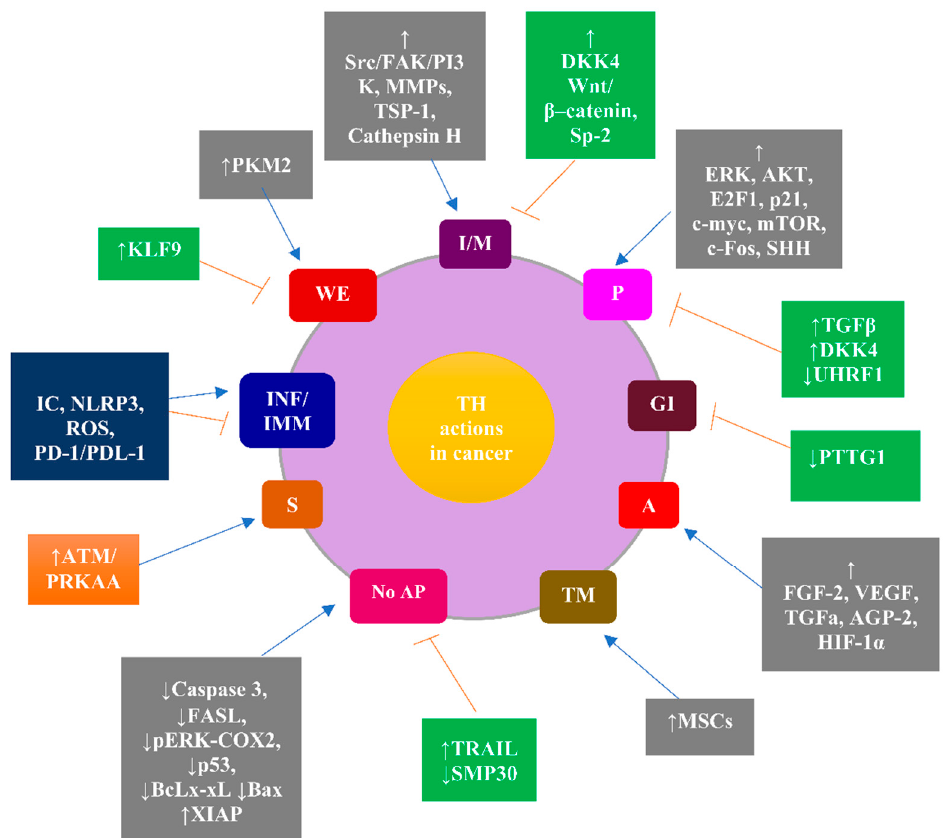
Figure 2. The contribution of THs to cancer hallmarks and to the senescence of cancer cells inte- grated by THs-modulated signaling molecules. Blue arrow: stimulation; Red arrow: inhibition. Ab- breviations: A, angiogenesis; AGP-2, angiopoietin 2; AKT, protein kinase B; AP, apoptosis; ATM,